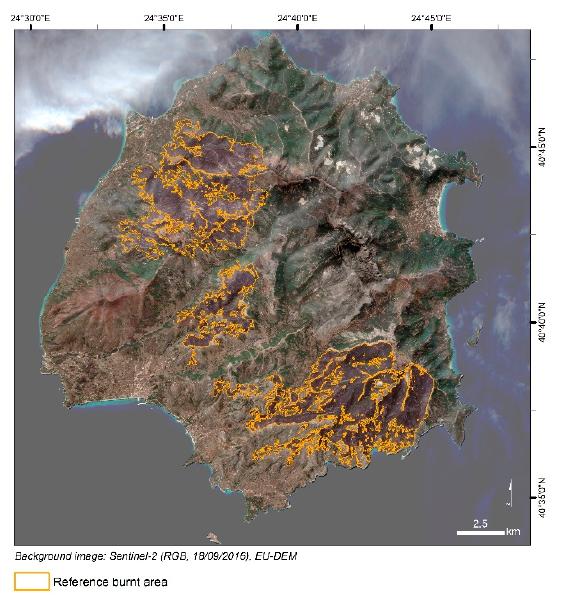
Figure 8. Reference burnt area data created using Sentinel-2 imagery and ancillary data.